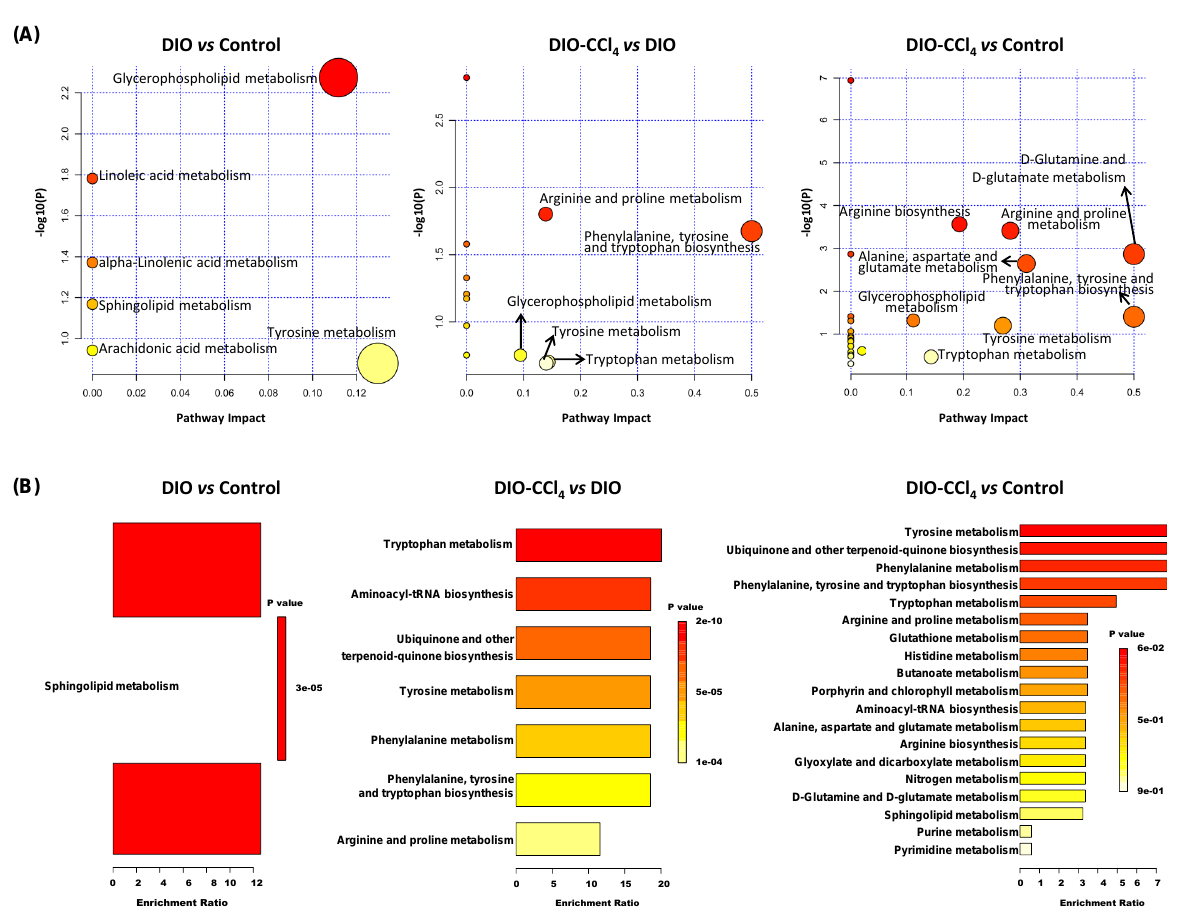
Figure 5. Pathway and enrichment analysis of liver perturbed metabolites. ( A ) Pathway analysis of the differential metabolites. ( B ) Enrichment analysis of the differential metabolites.